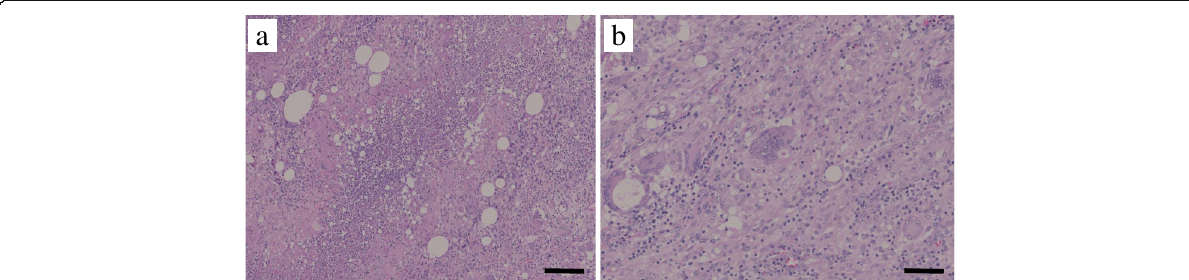
Fig. 4 Representative histological photographs of resected specimen (hematoxylin and eosin staining). a Main area of the tumor revealed the